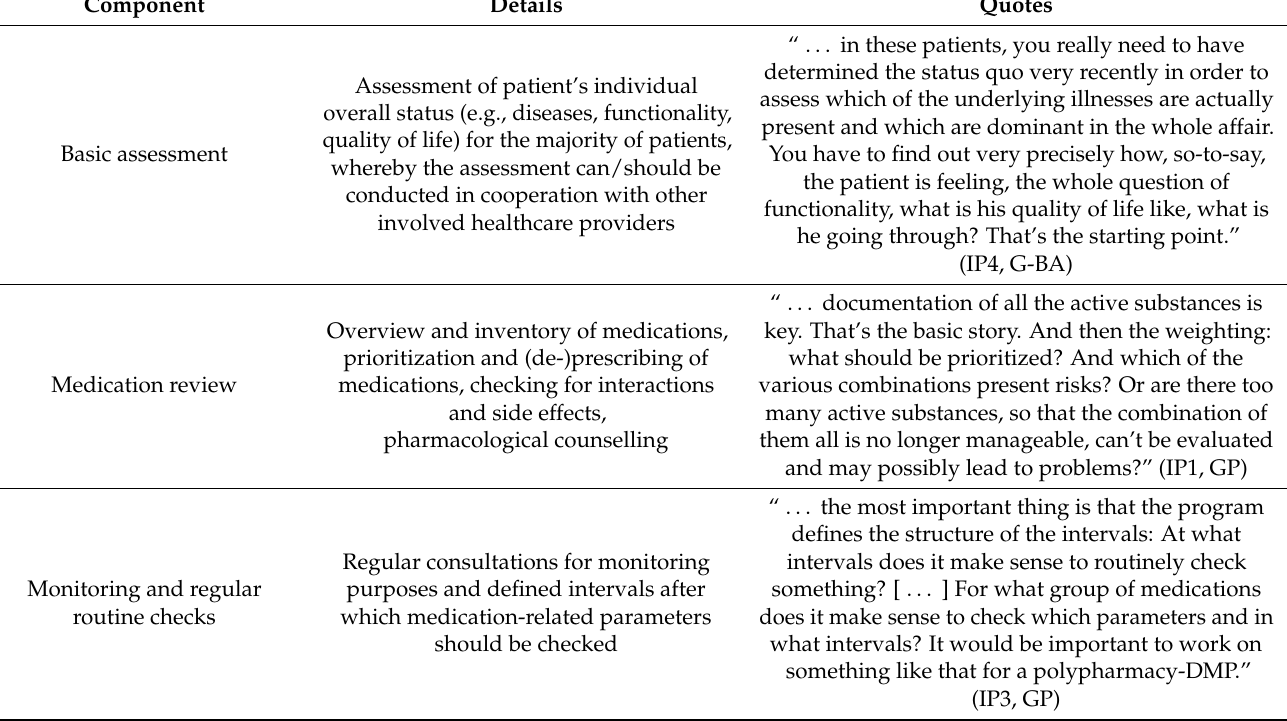
Table 1. Stakeholders’ suggestions on components of a polypharmacy management